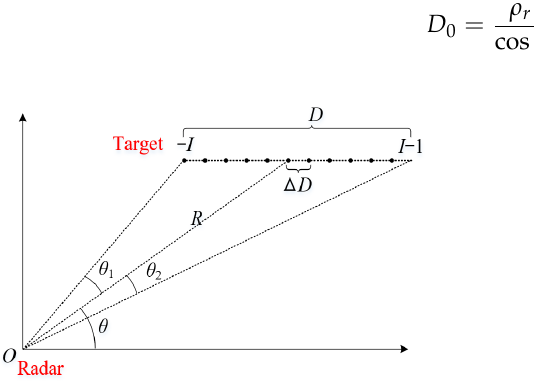
Figure 2. Schematic diagram of a range-spread target.